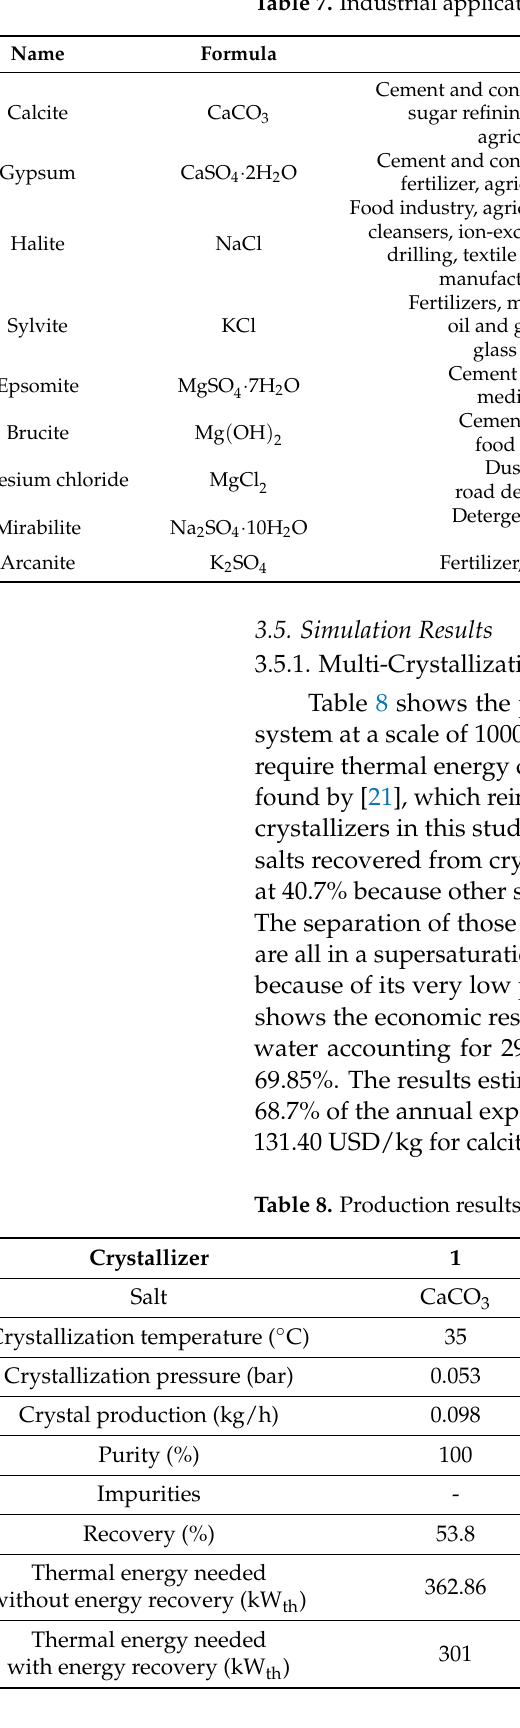
Table 7. Industrial applications of the different recoverable salts from brines.